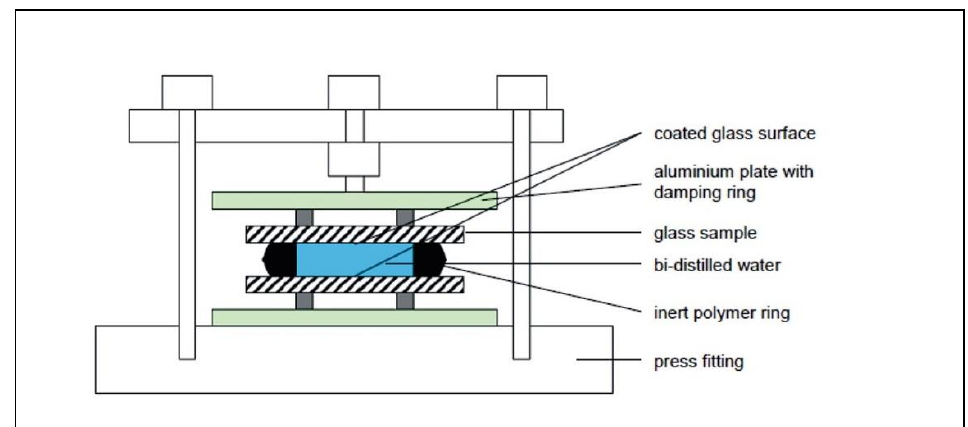
Figure 1. Scheme of the setup for leaching tests.